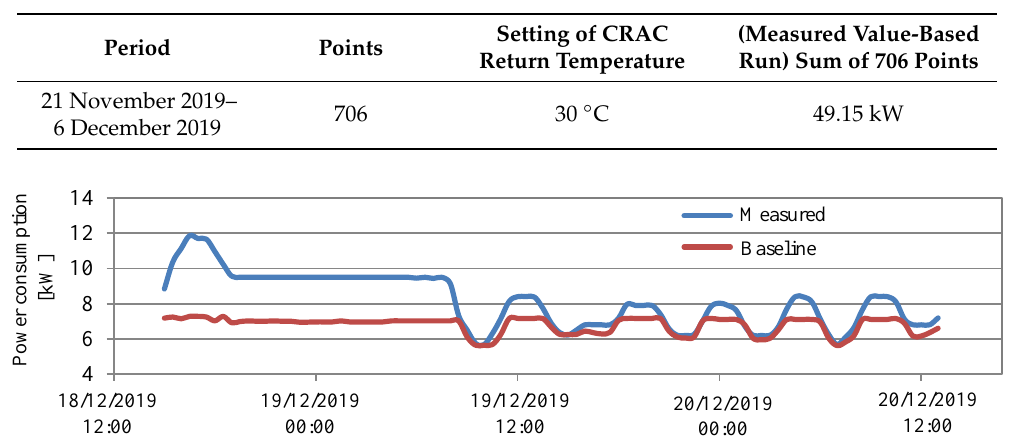
Table 24. Energy-saving e ff ect when return temperature of the CRAC is set to 30 ◦ C (21 November